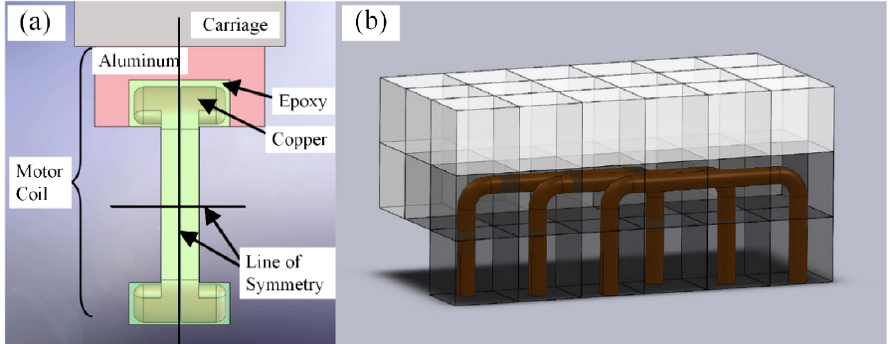
Figure 10. ( a ) Line of symmetry shown to reduce number of elements and ( b ) structure of elements for reduced model of motor coils. Reprinted with permission from ref. [83]. Copyright 2015 Elsevier Ltd.